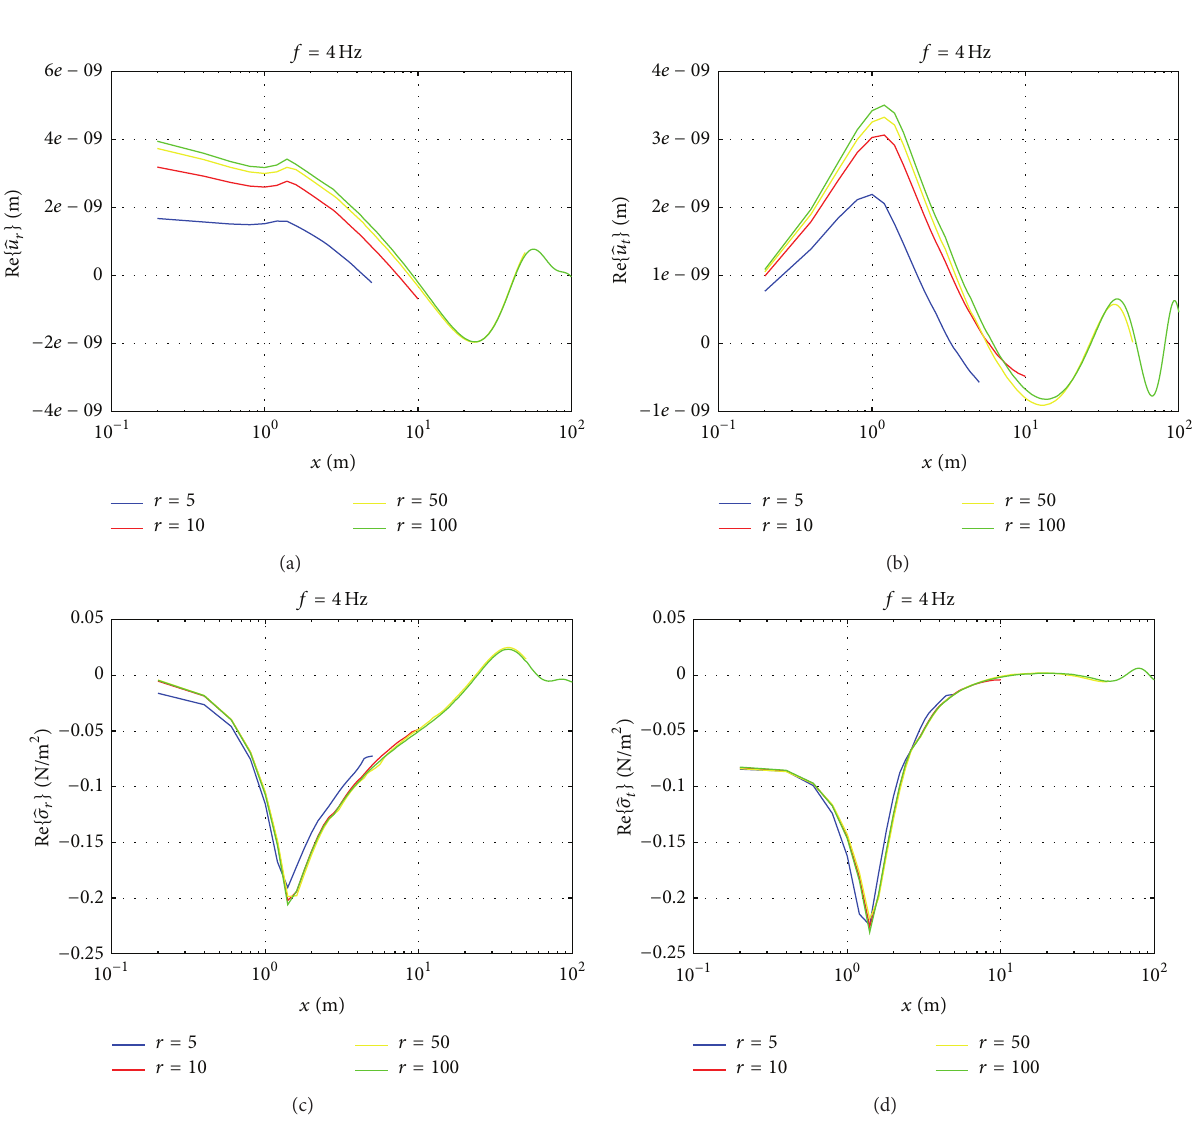
Figure 5: Radial displacement and stress for ℎ = 1 m and 𝑓 = 4